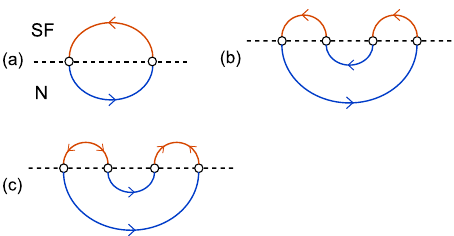
Fig. 2 Diagrammatic representation of tunneling processes between two reservoirs. The blue (red) lines and the circles represent Green ʼ s functions in the normal (super fl uid) side and the Rabi couplings Ω σ ,3 . a Lowest-order diagram, representing the normal single-particle tunneling. b Next-to- leading-order diagram, involving the nonlinear quasiparticle tunneling process. c Next-to-leading-order diagram, involving the Andreev re